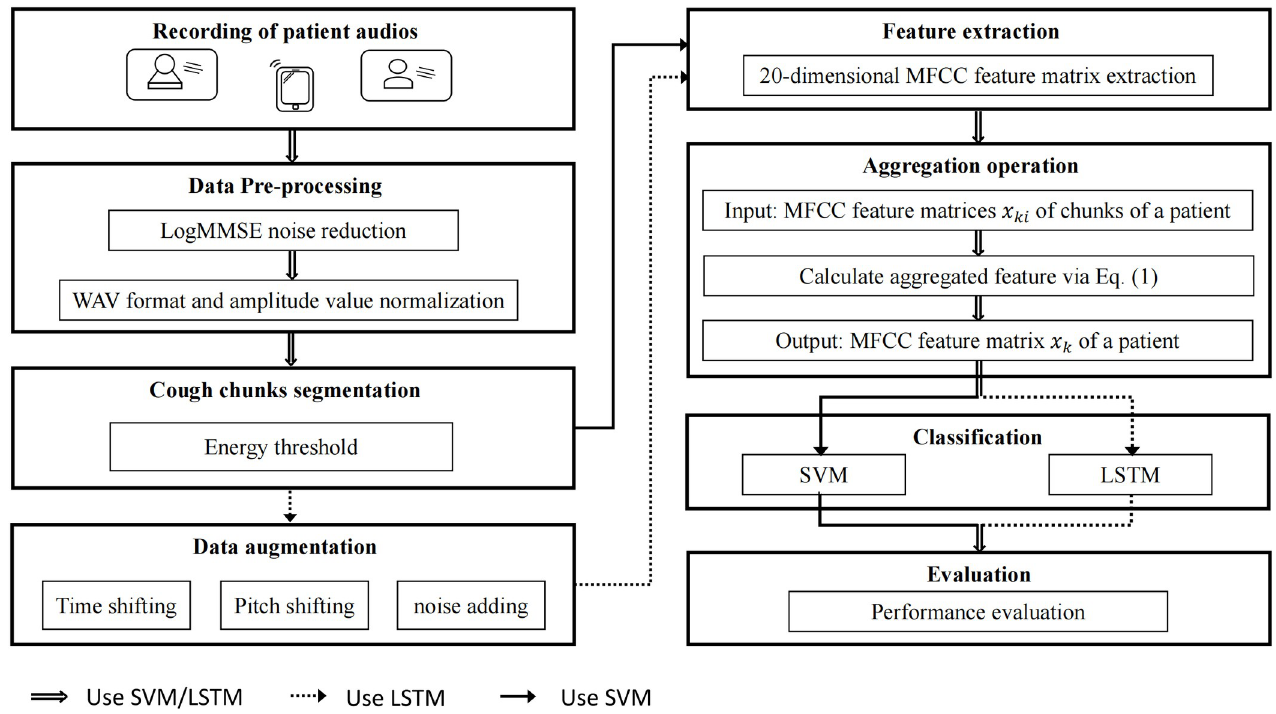
Fig 4. Structure of CFCS for classifying bronchitis and pneumonia in